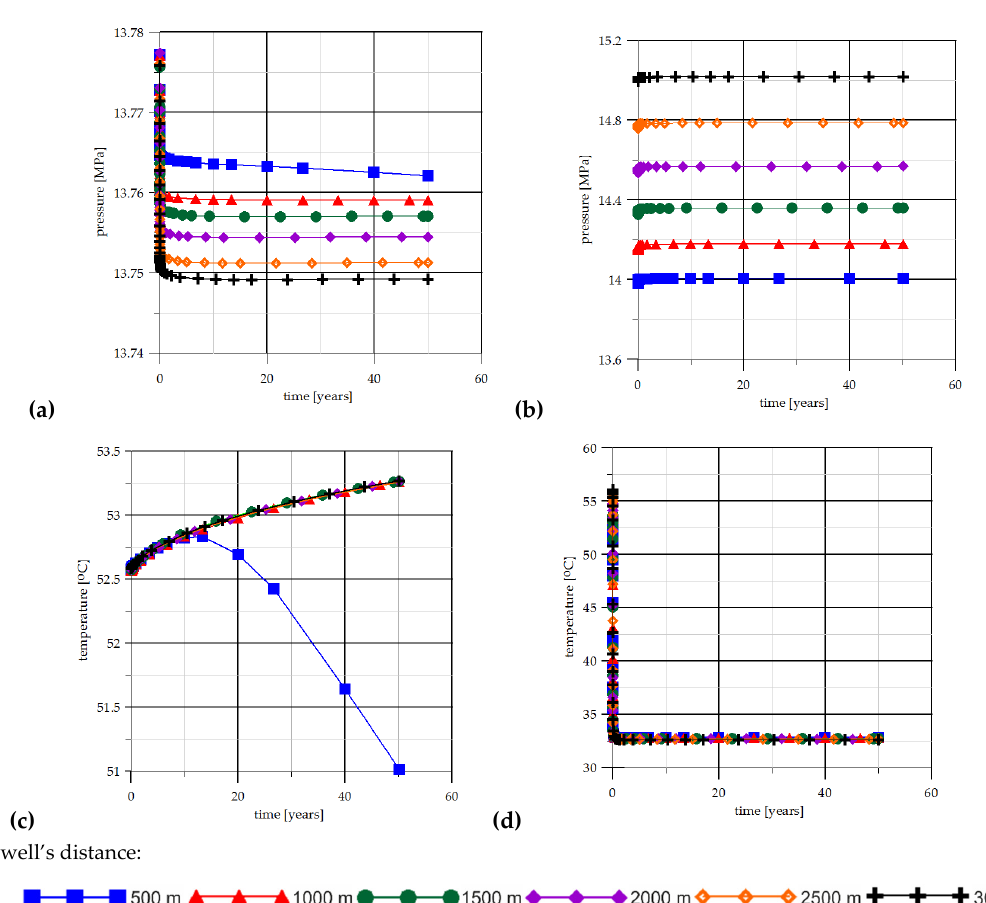
Figure 6. Changes of the pressure ( a ) in production and ( b ) in injection well zones, and temperature ( c ) in production and ( d ) in injection well zones for various densities of grid calculation.